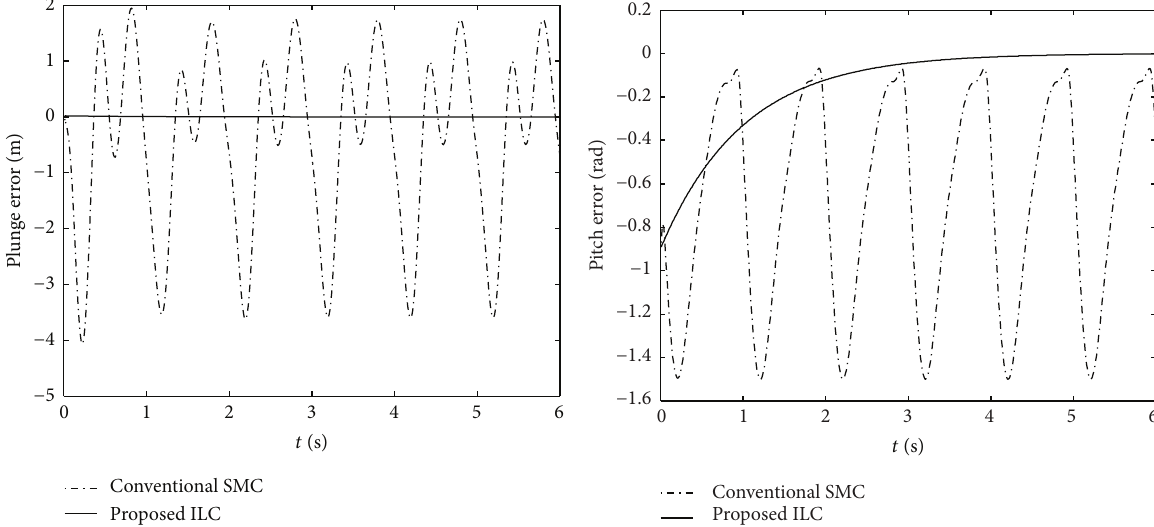
Figure 12: Comparison of the tracking error when 𝑥 ℎ,𝑑 = sin (2𝜋𝑡) , 𝑥 𝛼,𝑑 = 1 + sin (2𝜋𝑡) + 0.25 sin (4𝜋𝑡) .